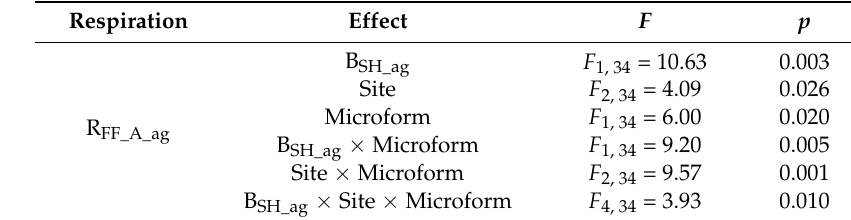
Table 4. Statistical results of a repeated, linear mixed effects model with fixed effects of site (control, experimental, drained), microform (hummock, hollow), and aboveground biomass of shrub + herb (B SH_ag ; covariate), random effect of plot, and an outcome variable of aboveground autotrophic respiration of shrubs + herbs at the forest floor (R FF_A_ag ) *.